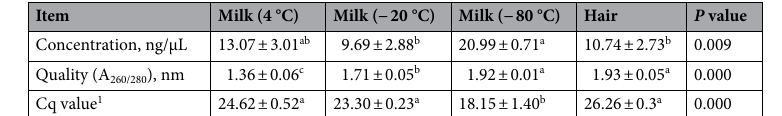
Table 1. Effect of both sample pre-treatment and matrix type on the quantity (ng/μL), quality (A 260/280 ) and qPCR results (Cq values) of DNA samples. Cq = Cycle number of crossing quantity (target CSN2 Table S1). Values are means ± standard error. a,b,c Means with different lowercase subscript were statistically different to each other ( P ≤ 0.05; Tukey’s test). 1 Lower values are associated with higher quantities of amplifiable